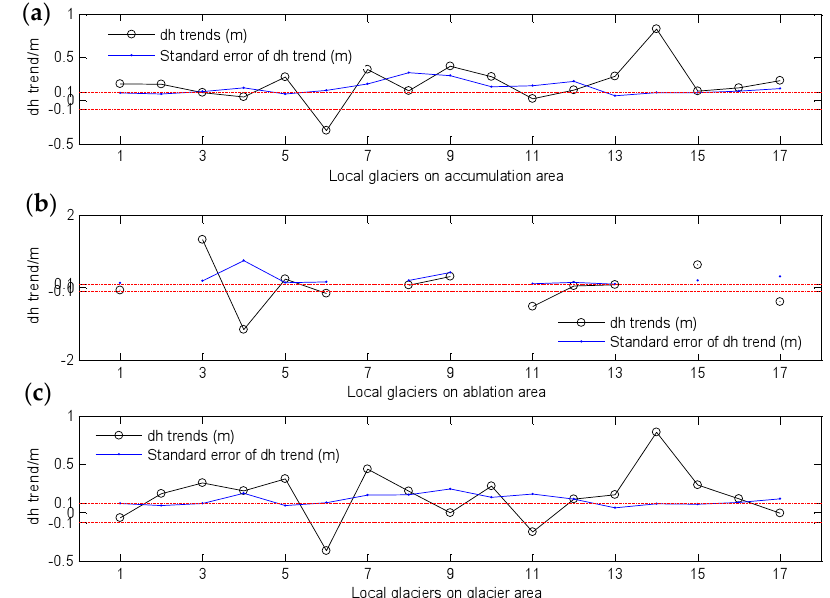
Figure 3. Trends of dh values between ICESat and SRTM during 2003–2008 for 17 local glaciers in the WKM region. Mean trends for individual glaciers are shown in different colors (red: thickening, blue: thinning, grey: in balance within ±0.1 m/a). ( a ) Winter, ( b ) autumn, ( c ) accumulation area, ( d ) ablation area, ( e ) on-glacier area, and ( f ) distribution of individual glaciers with ICESat measurements within the WKM region.